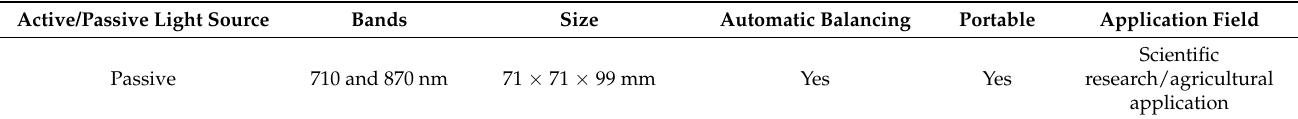
Table 2. The characteristics of the developed